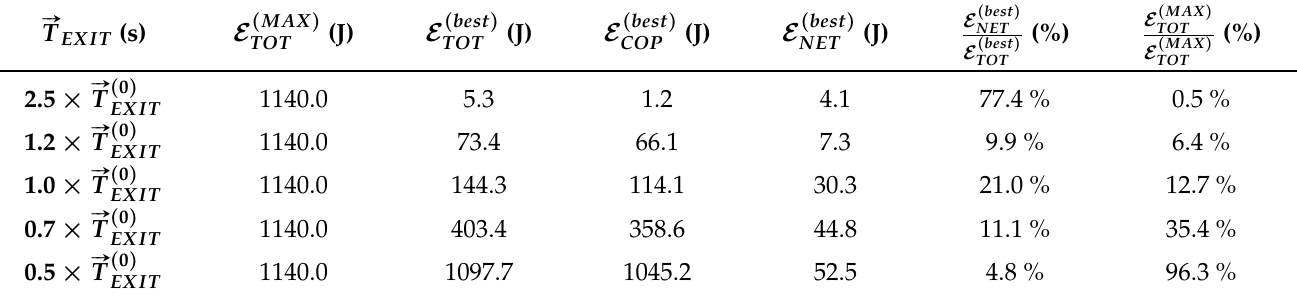
#» T EXIT (s) of the maximum allowed inference times under the simulated topology T Table 7. Energy sensitivity on the vector